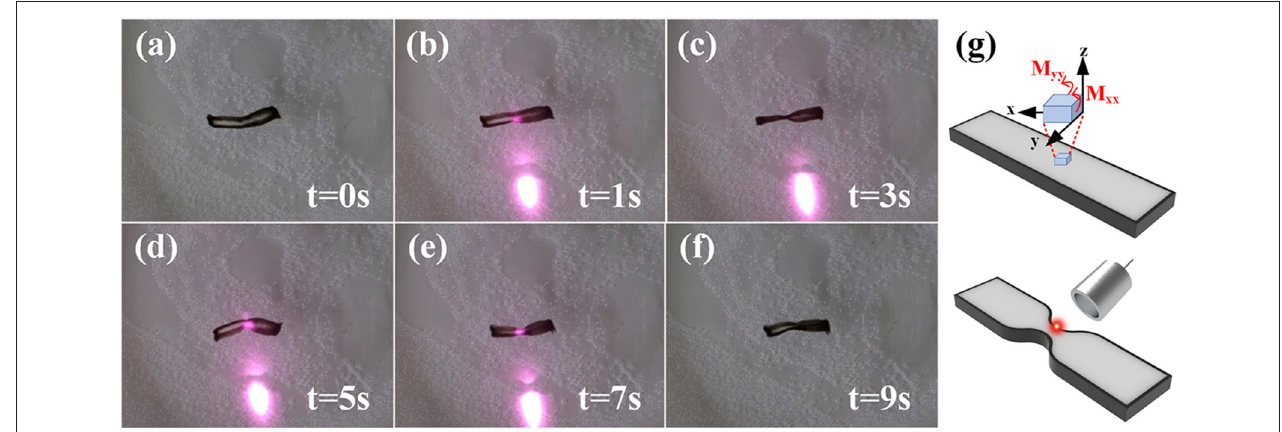
FIGURE 8 | The (a–f) multiple repetitive process and (g) a schematic diagram of rollover movement.